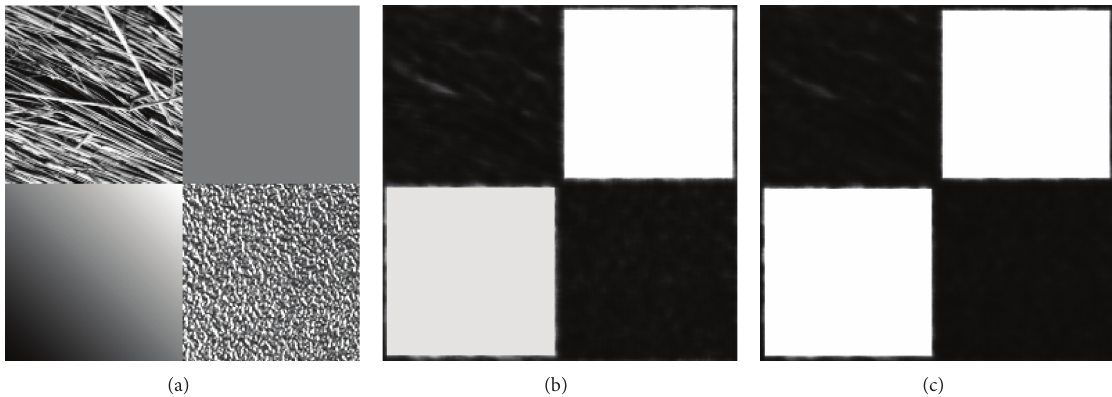
Figure 1: The numerical behavior of 𝑔 ∗ 1 and 𝑔 ∗ 2 ; here 𝛼 = 0.05 , 𝑀 = 0.05 , and 𝑟 = 7 : (a) the original image, (b) 𝑔 ∗ 1 , and (c) 𝑔 ∗ 2 .